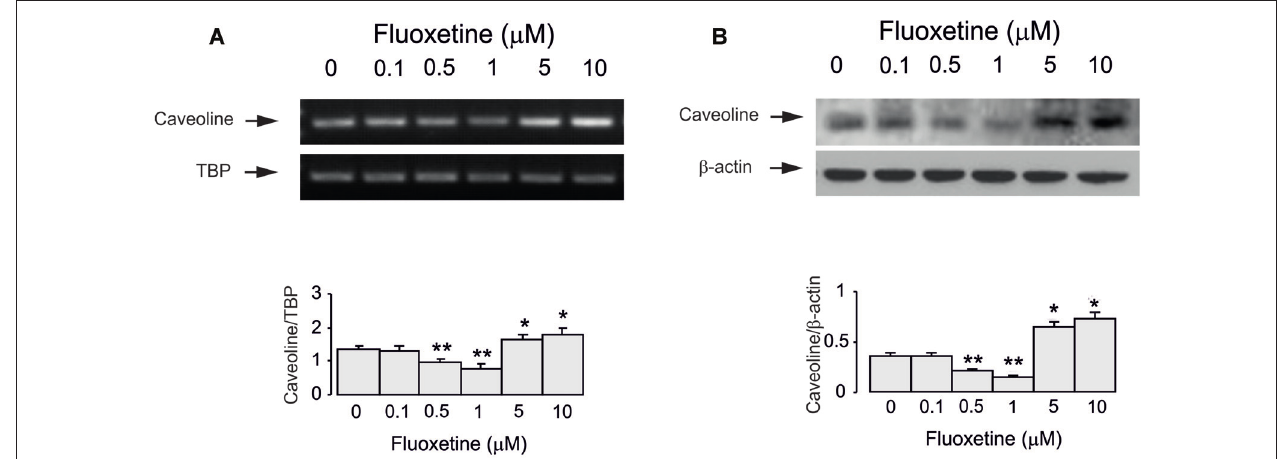
FIGURE 3 | Regulation of mRNA and protein expression of Cav-1 by chronic treatment with fluoxetine in astrocytes. Cells were incubated for 2 weeks in the absence of any drug (0 µ M fluoxetine, control) or in the presence of 0.1, 0.5, 1, 5, or 10 µ M fluoxetine. (A) Southern blot from representative experiment. Similar results were obtained from three independent experiments. Average mRNA expression was quantified as ratio between Cav-1 and TBP, used as a house-keeping gene. (B) Immunoblot from a representative experiment. Similar results were obtained from three independent experiments. Average protein expression was quantitated as ratio between Cav-1 and β -actin, used as a house-keeping gene. SEM values are indicated by vertical bars. ∗ Indicates statistically significant ( P < 0.05) difference from 0, 0.1, 0.5 and 1 µ M fluoxetine; ∗∗ indicates statistically significant ( P < 0.05) difference from all other groups but not from each